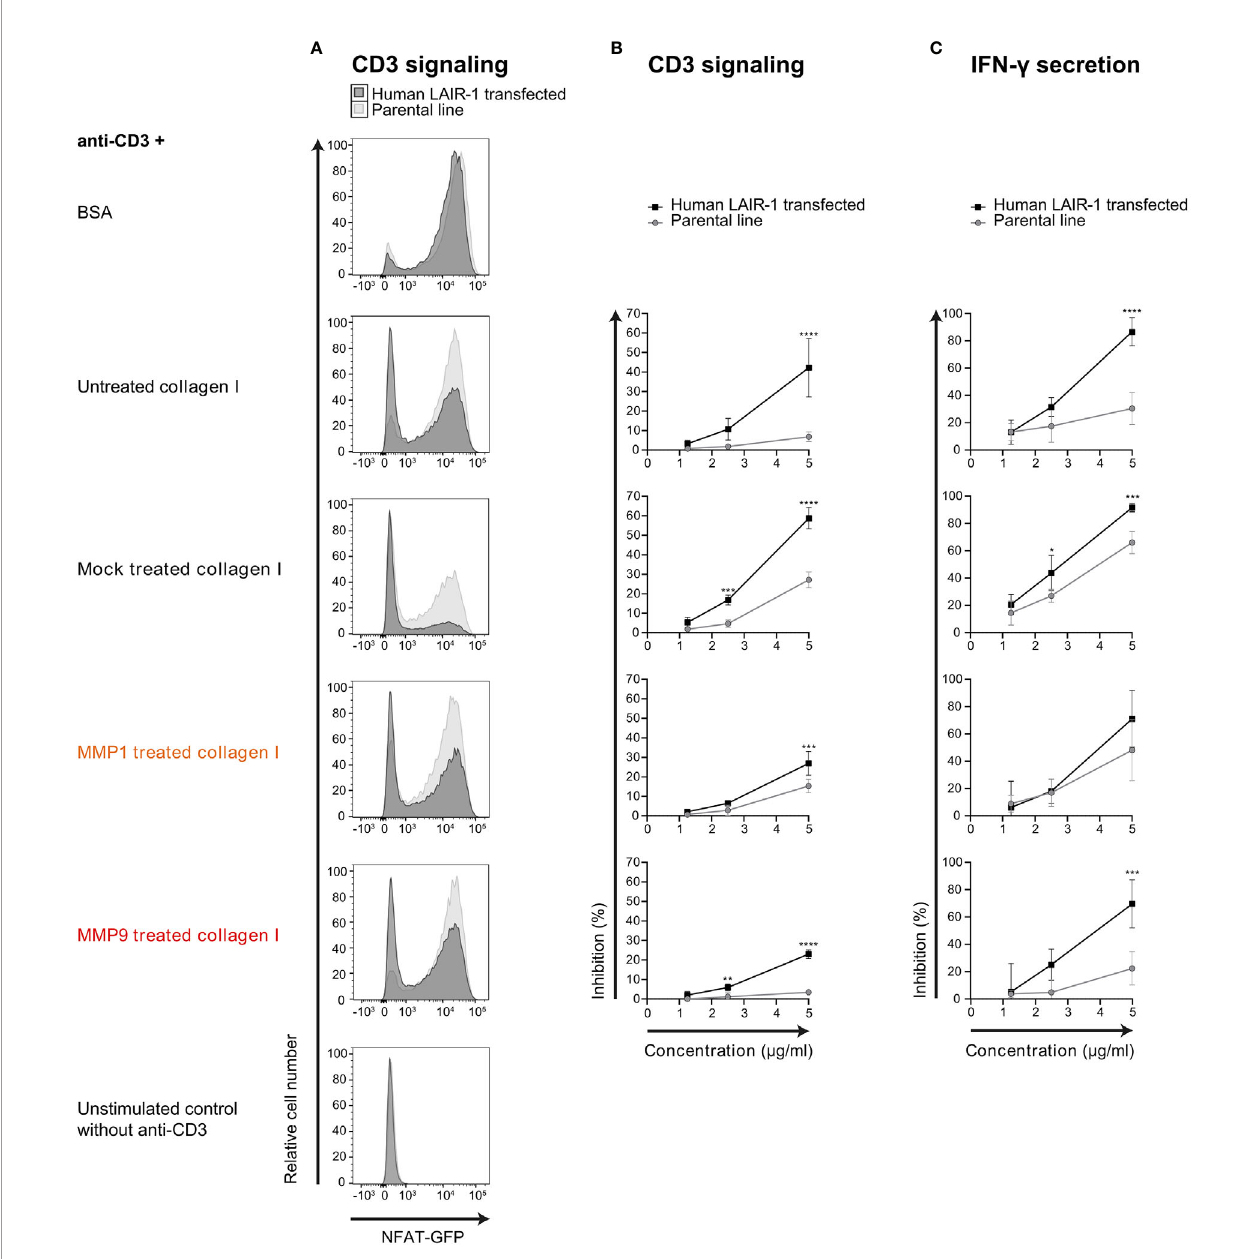
FIGURE 4 | MMP1 and MMP9 generated collagen I fragments inhibit T cell function through LAIR-1. (A) Flow cytometry analysis of parental (light grey) or full-length human LAIR-1 expressing (dark grey) NFAT-GFP CD3 reporter cells unstimulated, and stimulated with anti-mouse-CD3 in the presence of 5 m g/ml BSA, untreated collagen I, mock treated collagen I, MMP1 treated collagen I and MMP9 treated collagen I. (B) Inhibition of CD3-signaling-induced GFP expression by increasing concentrations of collagen or collagen fragments compared to BSA. (C) Inhibition of anti-CD3 induced IFN- g secretion by increasing concentrations of collagen or collagen fragments compared to BSA. Signi fi cant differences compared to the parental cell line are indicated, tested using a two-way ANOVA with Sidak ’ s multiple comparison